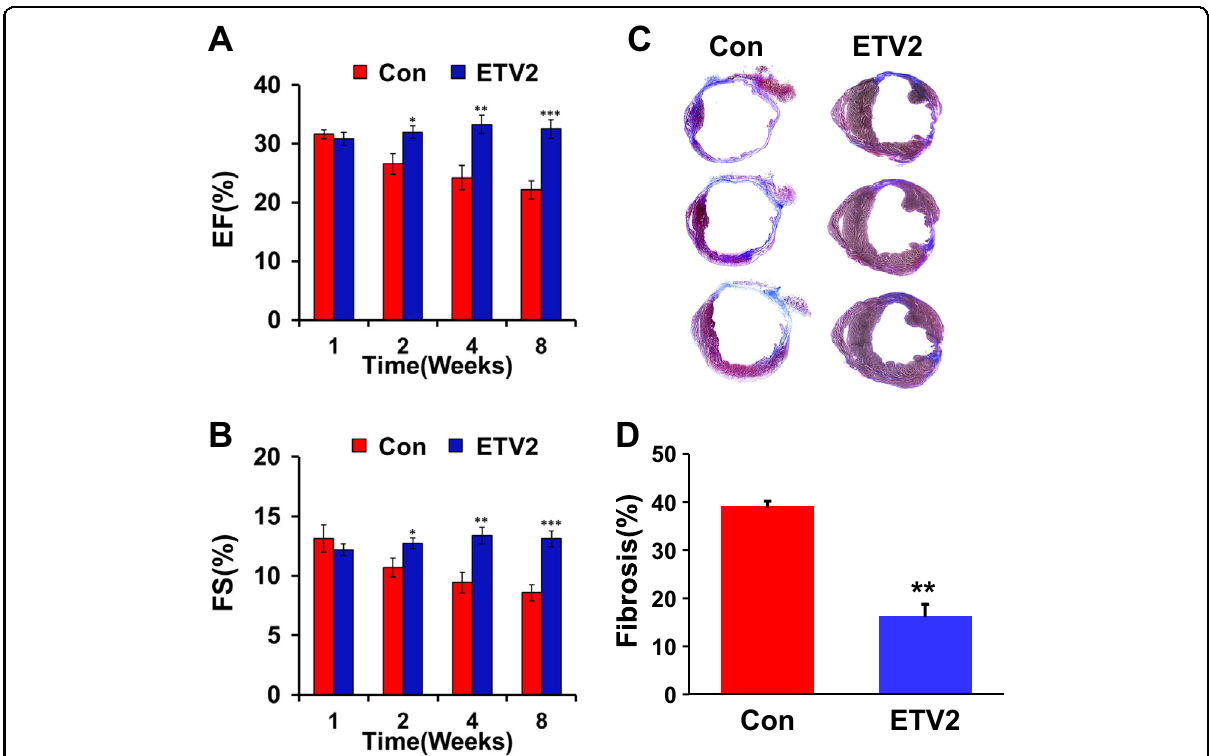
Fig. 3 Overexpression of ETV2 signi fi cantly improves cardiac function and reduces cardiac fi brosis in a mouse model of myocardial infarction. Mice undergoing MI were injected with lentiviral particles of ETV2-Ires-VENUS or control followed by echocardiography analysis. a , b Ejection fraction (EF) and fractional shortening (FS) were signi fi cantly higher in the ETV2-injected group compared to those in control virus-injected group, n = 7 – 10 for each group. c , d Representative images showing collagen deposition (blue) in the left ventricle of mouse hearts by Masson ’ s Trichrome staining. Bar graphs summarizing the percentage of fi brosis in the left ventricle of mouse hearts. For each heart, three randomly selected sections from the apex to ligated area were measured, n = 6 for each group. * p < 0.05, ** p < 0.01, and *** p < 0.001 compared to